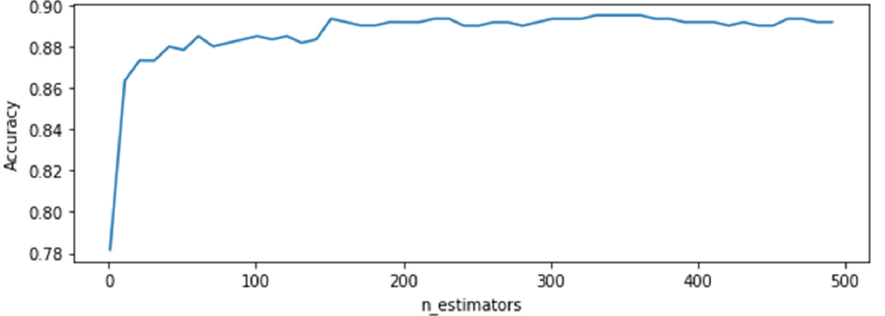
Figure 6. Accuracy—n_estimators’ curve (0–500).